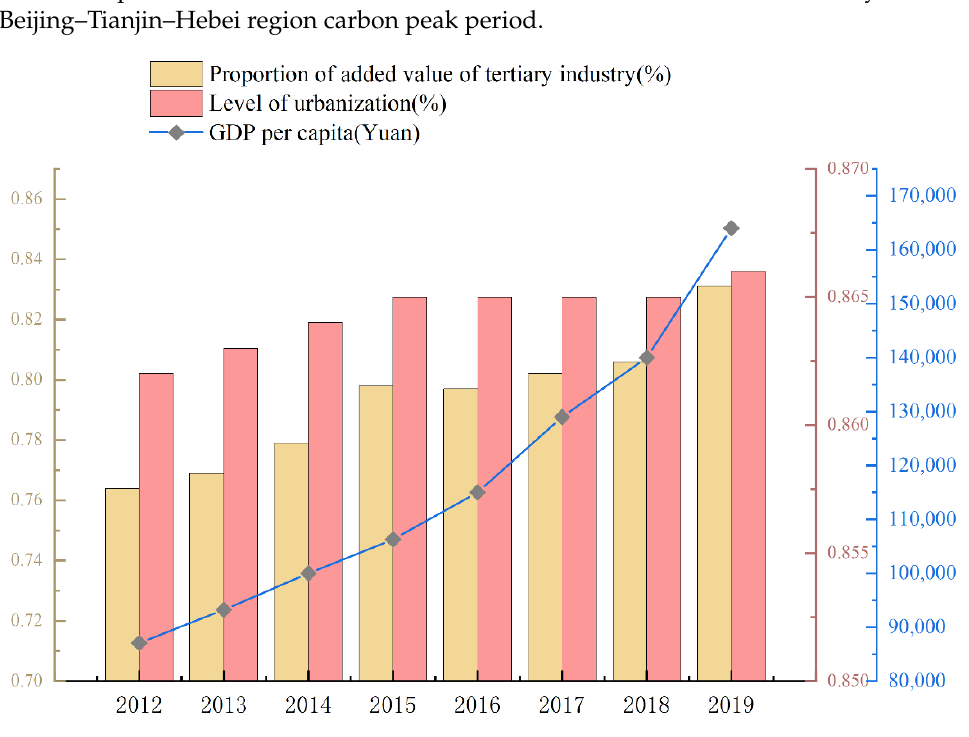
Figure 3. The development trend of indicators affecting the carbon peak period in Tianjin.